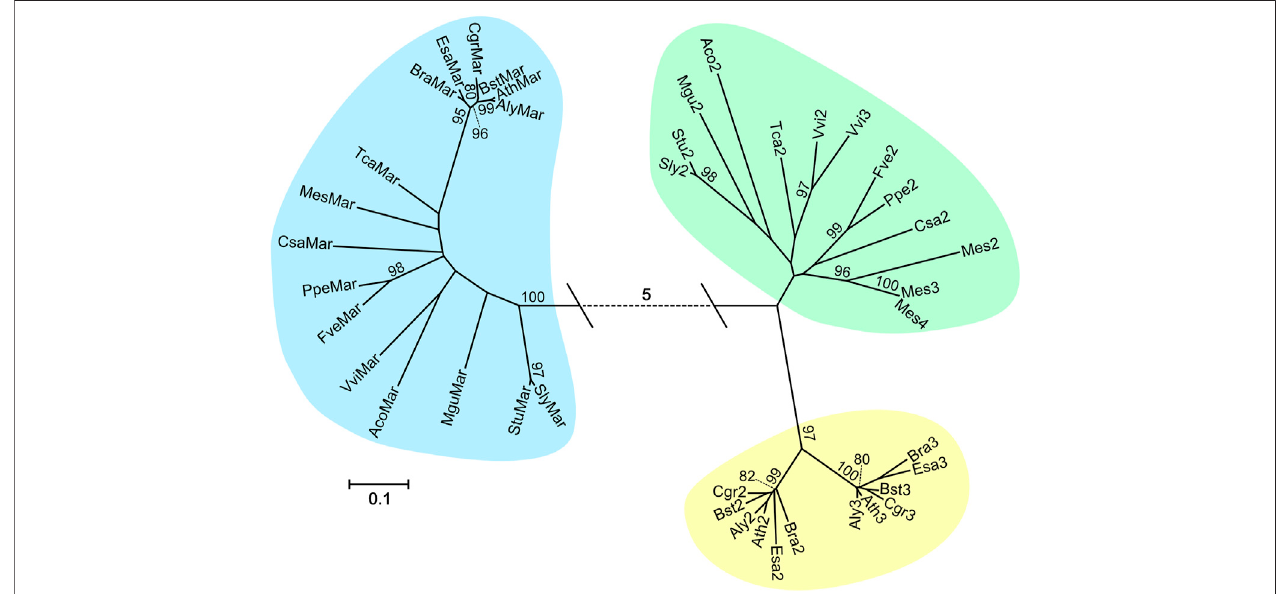
FIGURE 2 | Maximum Likelihood tree constructed with sequences similar to AtMAR1 from 16 vascular plant species. The tree with the highest log likelihood ( − 10803.58)isdisplayed.1,000bootstrap calculationswereperformedandonly valuesover80%areshown.Branch lengthsaremeasured inthenumber ofaminoacid substitutions per site (see legend). The dotted line represents a distance of fi ve substitutions per site. Species names and loci are given in Supplementary Table 4 , the corresponding multiple alignment is shown in Supplementary Figure 2 .